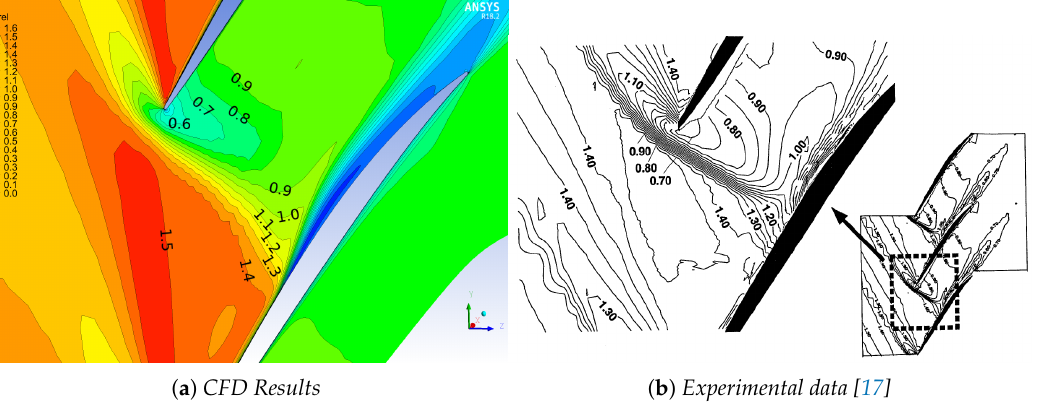
Figure 13. Contour of relative Mach number along the 70% stream-surface at near stall point condition (leading edge region